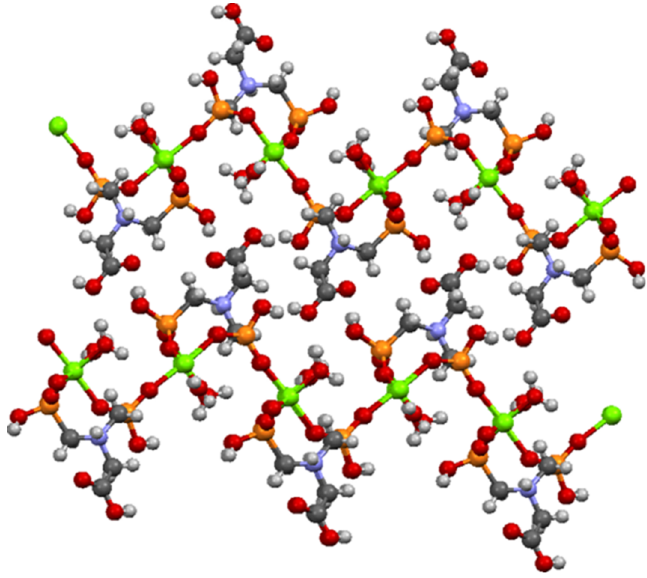
Figure 8. Partial view of two adjacent layers in the crystal structure of Mg–Gly model structure.